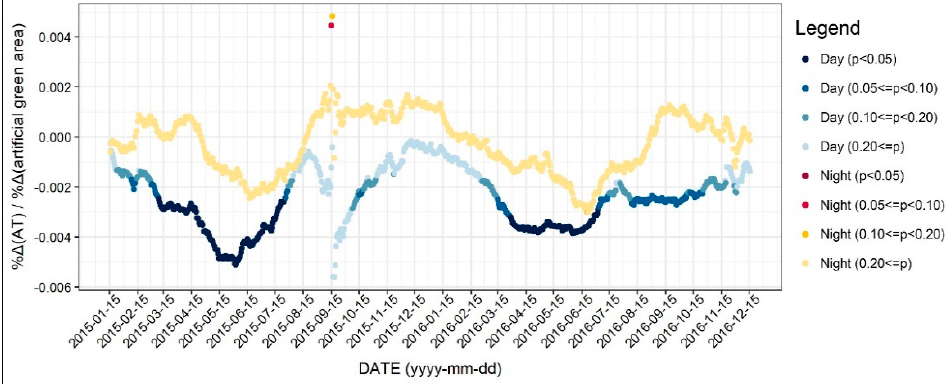
Figure 14. Changing patterns in the regression coefficients and their significances (sky view factor). Figure 15. Changing patterns in the regression coefficients and their significances (artificial green Figure 15. Changing patterns in the regression coe ffi cients and their significances (artificial green area).